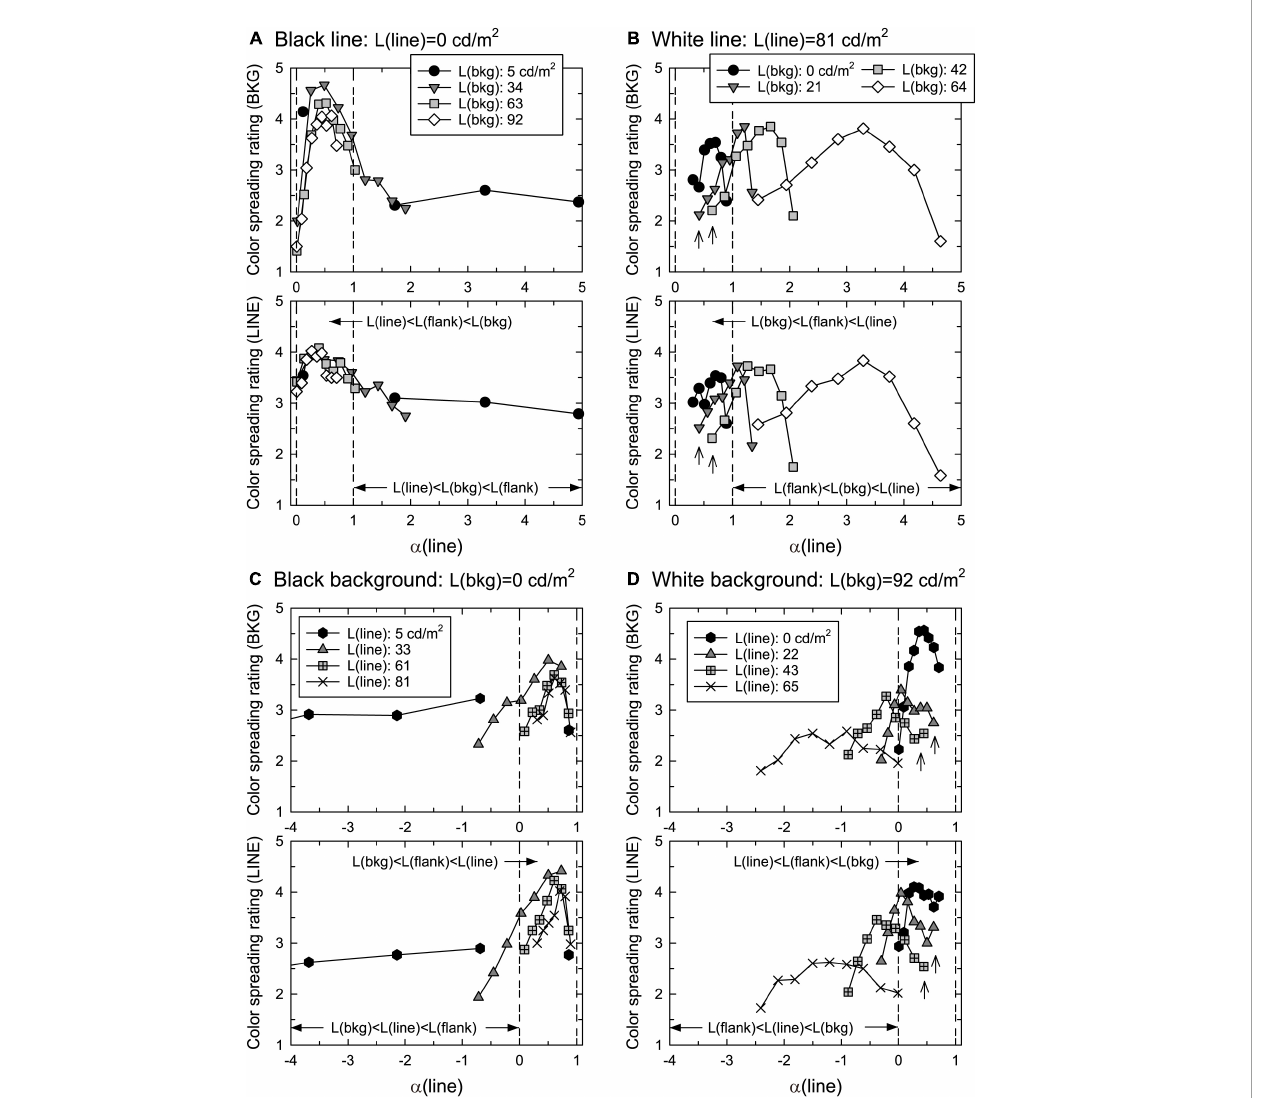
FIGURE4 Mean confidence ratings of color spreading as a function of α (line) in (A) black-line, (B) white-line, (C) black-background, and (D) white-background conditions. Top and bottom figures in each luminance condition show the rating of color spreading over the background and line segments, respectively. Two vertical dashed lines in each panel show the range of 0 < α (line) < 1. The upward arrows in panels (B,D) indicated the ratings that were not high even when α (line) was around